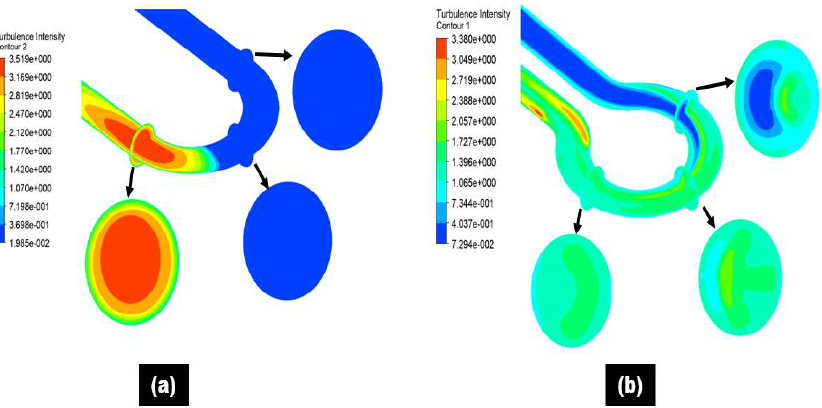
Figure 13. Turbulence intensity at the different locations inside the elbow pipe for 250 µm particle size: ( a ) 180° U−bend; ( b ) double offset U−bend.